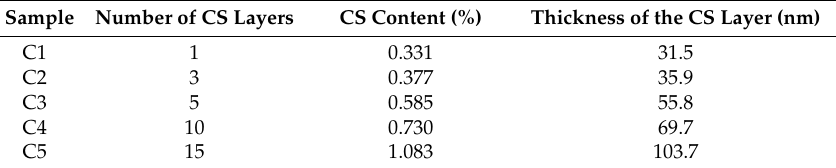
Table 2. Conditions (C1–C5) used during the CS coating of the P1 PLA-fiber sample.